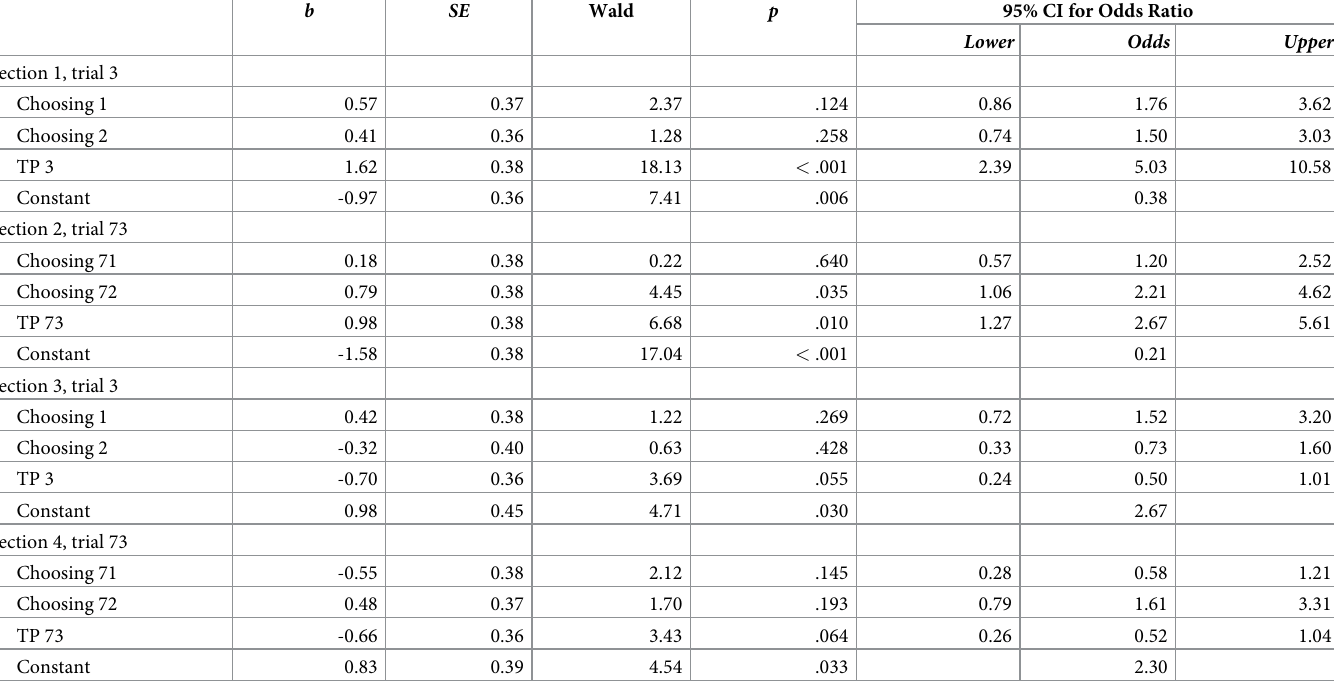
Table 6. Experiment 3: Results of logistic regression predicting choosing on second and third recognition test trials based on previous choosing and target- presence. b SE Wald p 95% CI for Odds Ratio